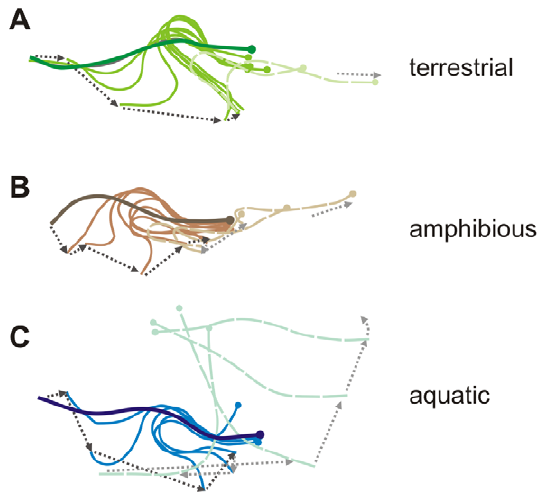
Figure 2. Dorsal midline splines taken from high-speed video of representative, stereotypical terrestrial jumps. Presented midlines include a a , terrestrial ( Andamia tetradactyla ), b , amphibious ( Praealticus labrovittatus ), and c , aquatic ( Blenniella gibbifrons ) blenny. The head is indicated by the filled circle, and the darkest midline corresponds to initial body position before movement. Lighter solid midlines indicate the body is contact with the ground, whereas the lightest dashed midlines indicate that the body is raised off the ground. Note the large yaw of the aquatic blenny, c , as its body leaves the surface. Dotted arrows indicate tail movement or overall body movement.